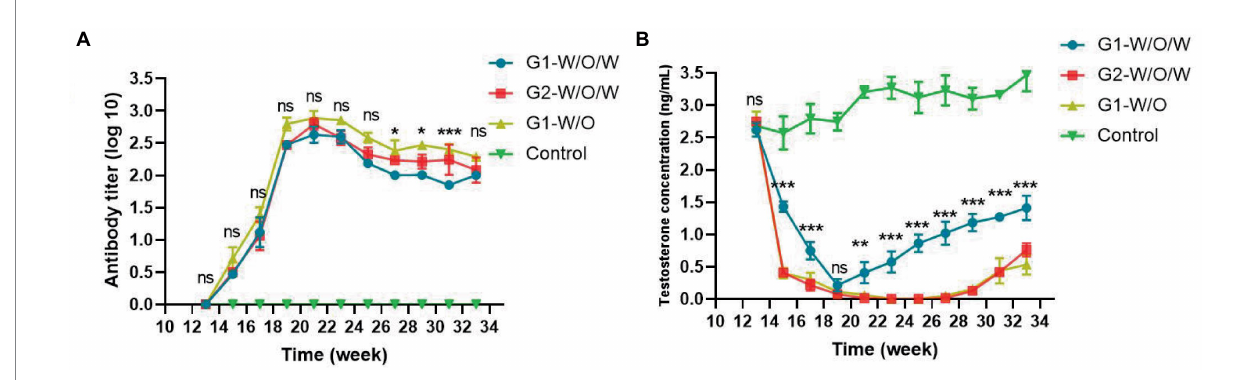
FIGURE 3 (A) Results of GnRH antibody titer in boar serum. The serum antibody titers of boars treated with GnRH were significantly different from the control group ( p < 0.05). (B) After immunization with GnRH, the concentration of testosterone in boar serum was measured (in ng/mL). The results showed that the serum testosterone level in treated boars was lower than 0.1 ng/ml, and there was a significant difference when compared with the control group. The result in the picture shows the comparison between the G1 W-O-W group and the G2 W-O-W group. ns indicated that there was no significant difference. * p < 0.05, ** p < 0.01 and *** p < 0.001.